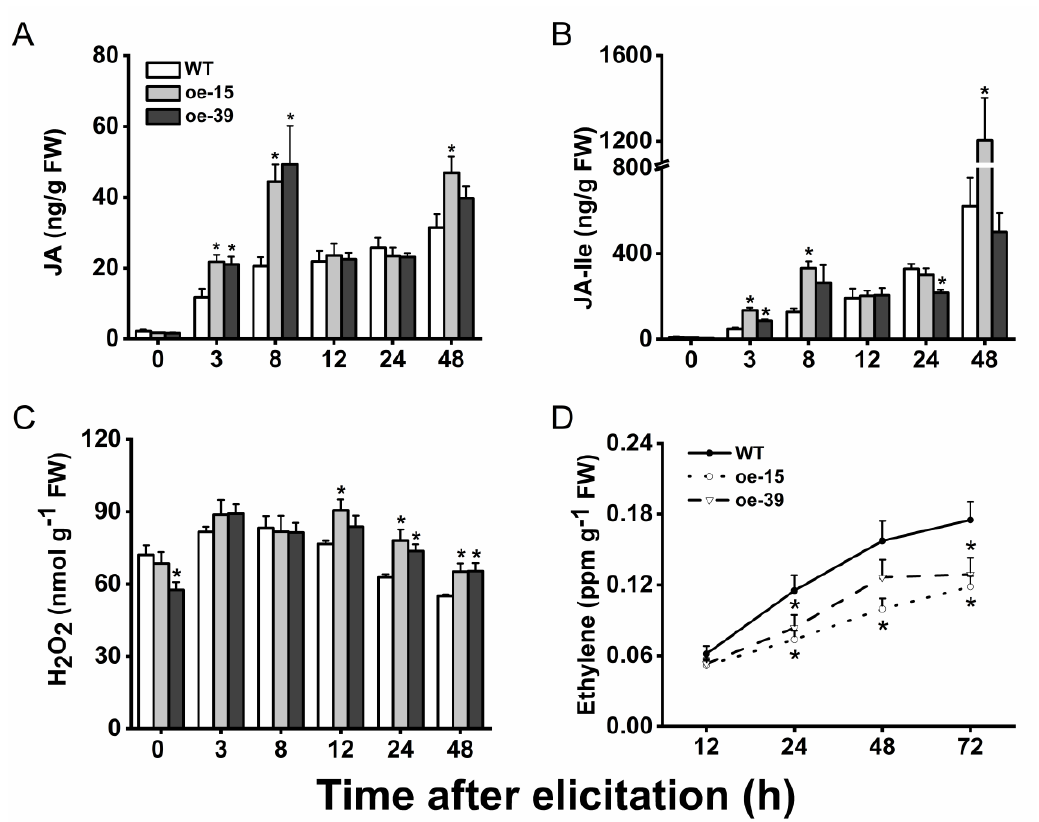
Figure 6. Os6PGDH1 mediates BPH-induced accumulation of JA, JA-Ile, H 2 O 2 , and ethylene, but not SA. Levels (means + SE, n = 6) of JA ( A ), JA-Ile ( B ), H 2 O 2 ( C ), and ethylene ( D ) in oe6PGDH lines and WT plants at indicated time points after they were individually infested by 15 gravid BPH females. Asterisks indicate significant differences in oe6PGDH lines compared with WT plants (one-way ANOVA followed by Duncan’s multiple range test, p < 0.05).